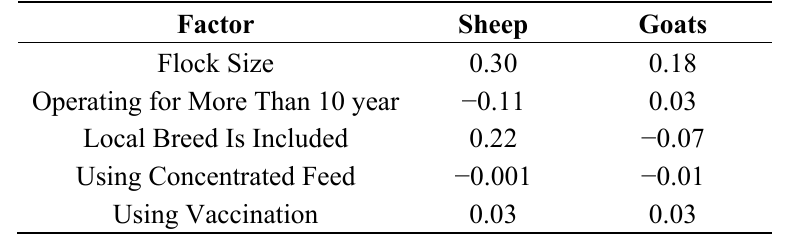
Table 8. Sources of technical efficiency in sheep and goats: correlation